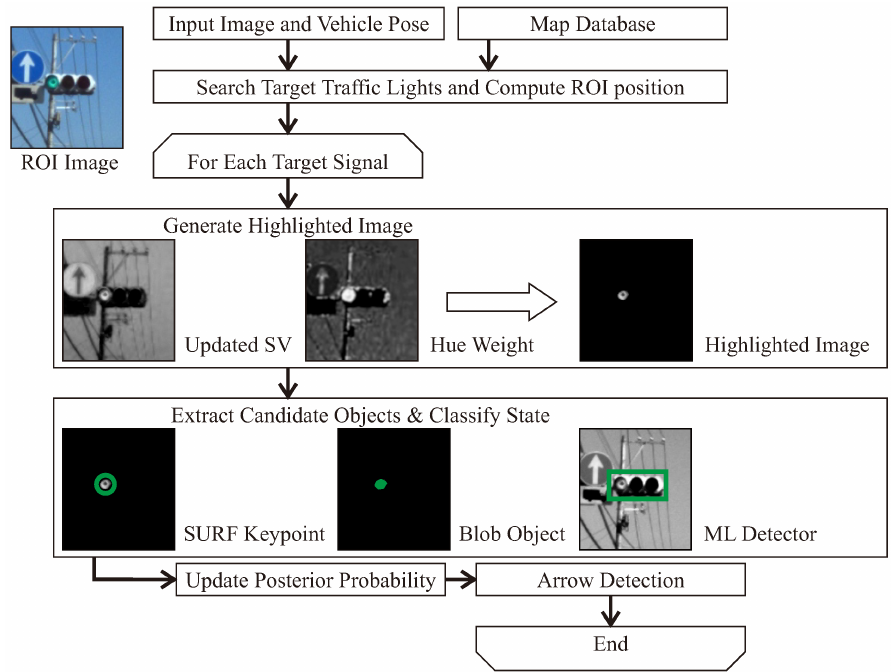
Figure 14. Flowchart of the method proposed in